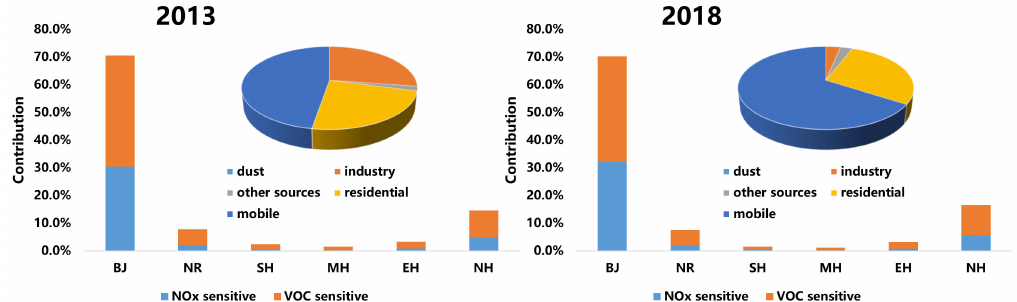
Figure 4. Source apportionment of O 3 in January 2013 and 2018. Column charts representing the contribution of O 3 related to NOx-sensitive and volatile organic compounds (VOC)-sensitive areas; pie charts representing the local emission